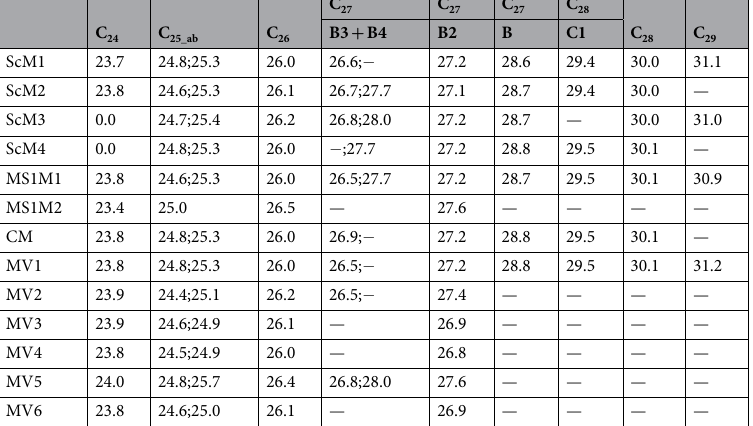
Fig. 3 presents a dendrogram reflecting the similarity between the synthesized samples and the historical samples, considering the relative percentages of different mauveine compounds identified in Fig. 2. This provides a two-dimensional diagram of the data structure, indicating the merging samples and the merging distances. Five groups of samples are identified at a distance of 30, and reflect the C 26 /C 27 ratio (sum of all C 26 and all C 27 com- pound percentages). For instance, the group on the top includes the samples MS1M1 and ScM2 with the lowest C